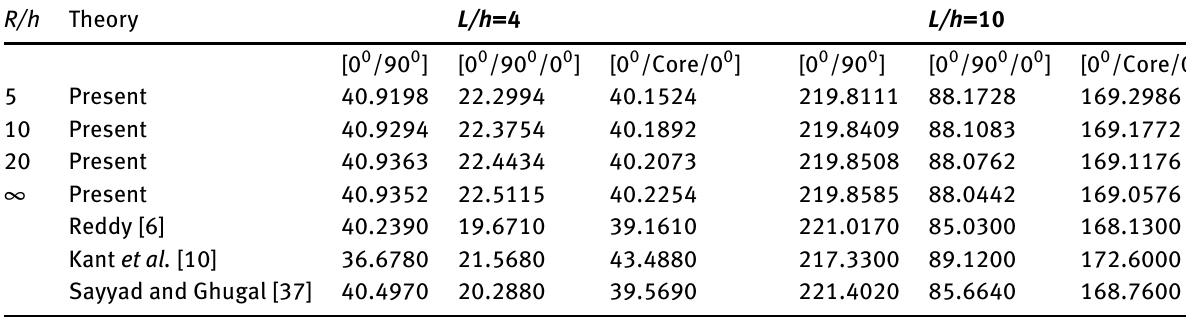
Table 4: Normalized bending stresses ( ¯ σ x ) of simply-supported laminated composite and sandwich curved beams.